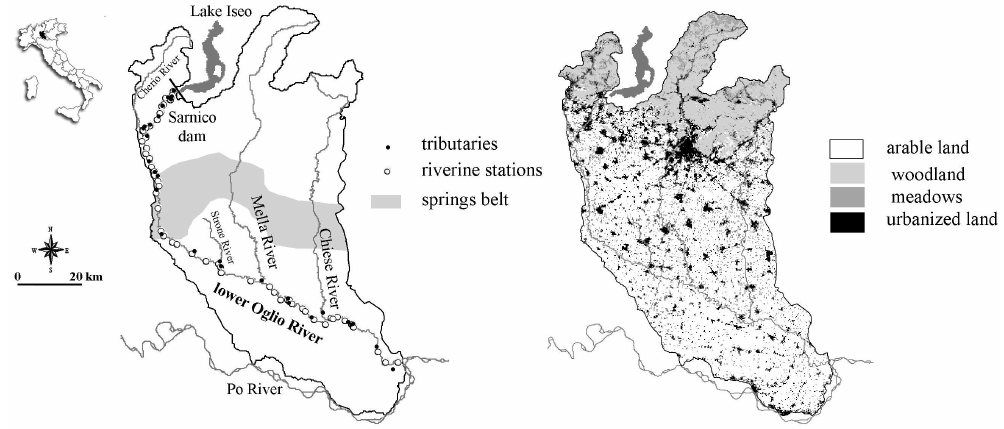
Fig. 1. The map on the left shows the lower Oglio River, its main tributaries, the area within the basin where springs are located and the sampling stations; the map on the right reports the land use within the basin. With lower Oglio River and lower Oglio basin we indicate the river segment that originates from the Lake Iseo and flows into the Po River and its associated watershed.